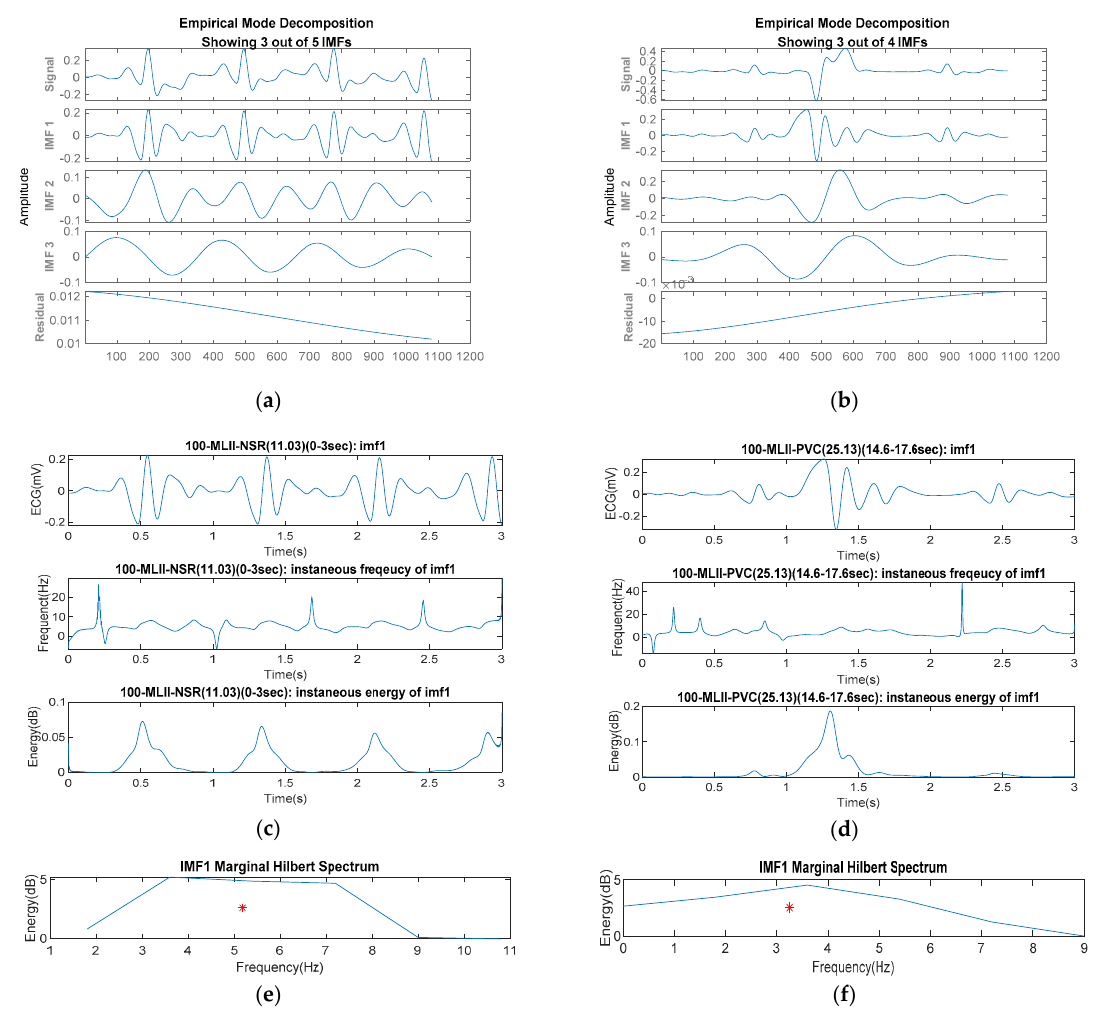
Figure 3. Spectrum analyses in the time–frequency domain due to the HHT process for normal and arrhythmia ECG signals exemplified by NSR and VPC: ( a ) NSR IMFs due to the fact of EMD; ( b ) VPC IMFs due to the fact of EMD; ( c ) NSRs’ instantaneous frequency and energy; ( d ) VPCs’ instantaneous frequency and energy; ( e ) NSR MHS and centroid (red star) for IMF1; ( f ) VPC MHS and centroid (red star) for IMF1.